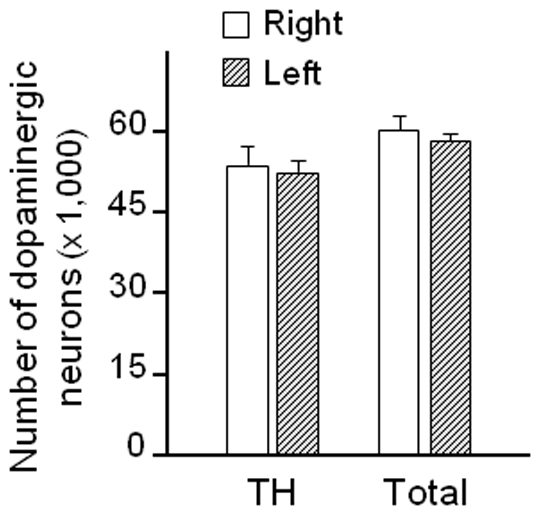
The number of nigral dopaminergic neurons is not affected by siRNA-induced α-synuclein suppression.Squirrel monkeys received a unilateral nigral infusion of siRNA targeting α-synuclein. Both the number of TH-immunoreactive cells and the total number of dopaminergic neurons were counted stereologically in the substantia nigra. Values (mean ± SEM) were not different between the right (untreated) and left (siRNA-infused) hemisphere.